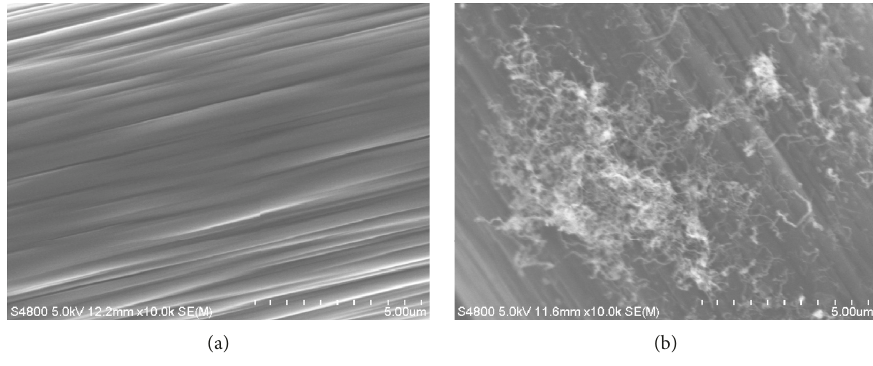
Figure 1: SEM images of pristine GF and (a) hydroxyl MWCNTs/GF (b). Table 1: Resistivity and conductivity of different samples.